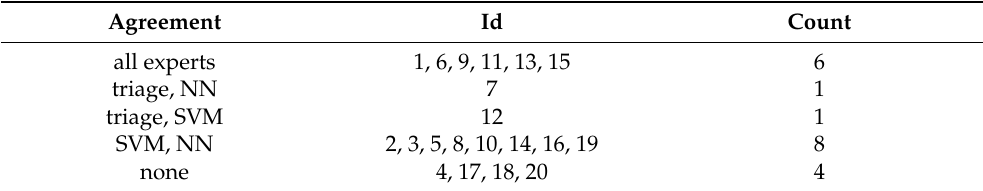
Table 7. Agreements between SNS24 triage, neural network, and SVM experts for 20 examples. The Id column indicates the texts that the experts agreed with, and the referring text can be found with the Id in Table A2. The Count column calculates the total number of agreements among the experts. Agreement Id Count all experts 1, 6, 9, 11, 13, 15 6 triage, NN 7 1 triage, SVM 12 1 SVM, NN 2, 3, 5, 8, 10, 14, 16, 19 8 none 4, 17, 18, 20